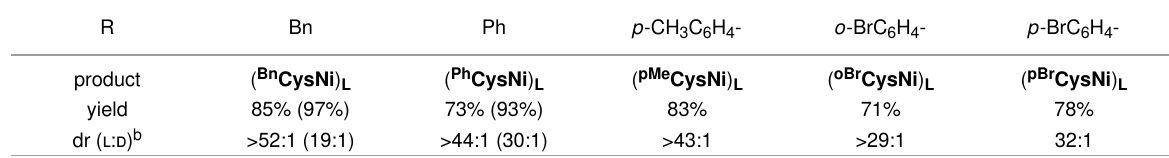
Table 1: The yields and the thermodynamically controlled stereoselectivity observed in the thiolation of ( Δ AlaNi ) L7 complexes with RSH; and compar- ison with the data for ( Δ AlaNi ) L1 reported previously [41] given in parentheses. a R